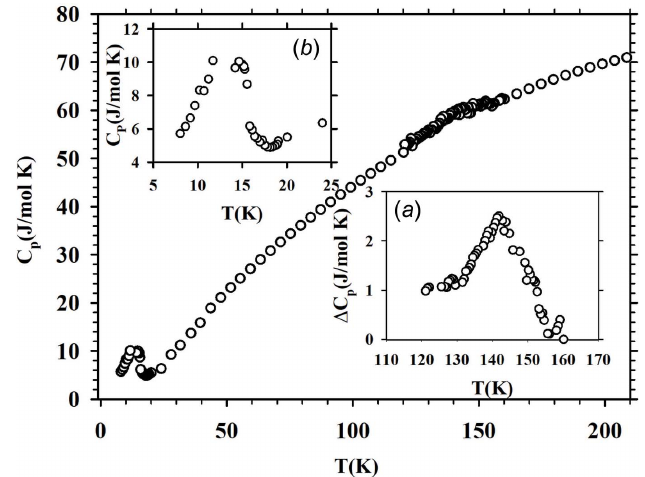
Figure 5 Temperature dependence of the specific heat C p from 8 to 210 K. The lower inset ( a ) provides an enlarged view around the anomaly at 145 K, where (cid:3) C = 2.5 J mol (cid:3) 1 K (cid:3) 1 . The upper inset ( b ) displays C p versus T at low temperatures in the range 8–25